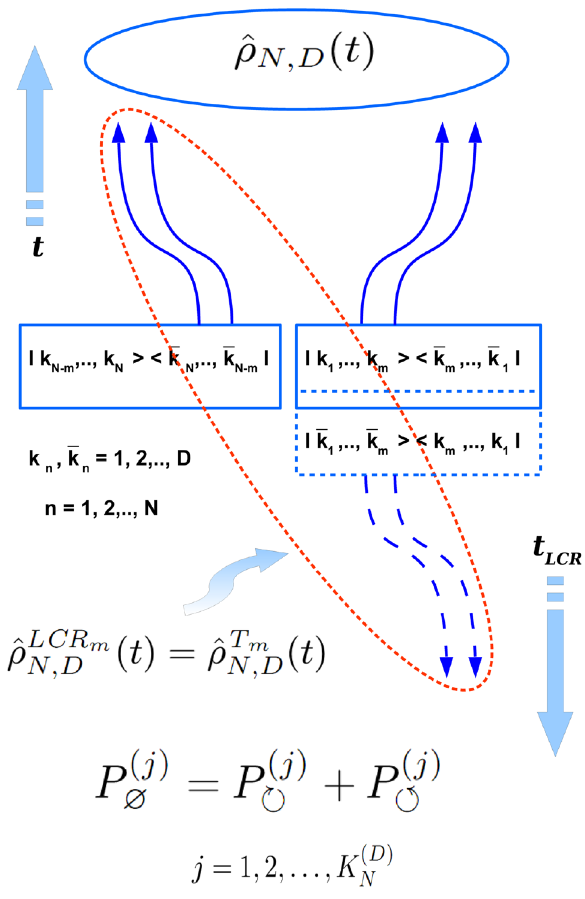
N Hilbert space (encoding N 1, 2, . . . N 1 ). All the scheme represents = − 1, 2, . . . D (instead of 1, 2 on Fig. 1) and = 1 case on Fig. 1). Besides 1 (instead of m = −